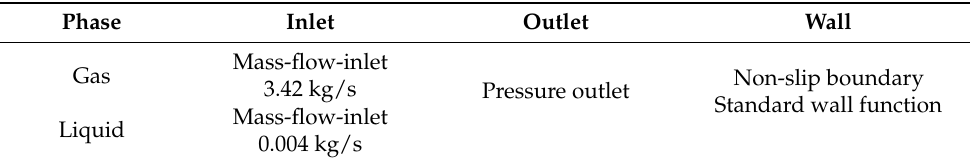
Table 6. Boundary condition for the Eulerian model.